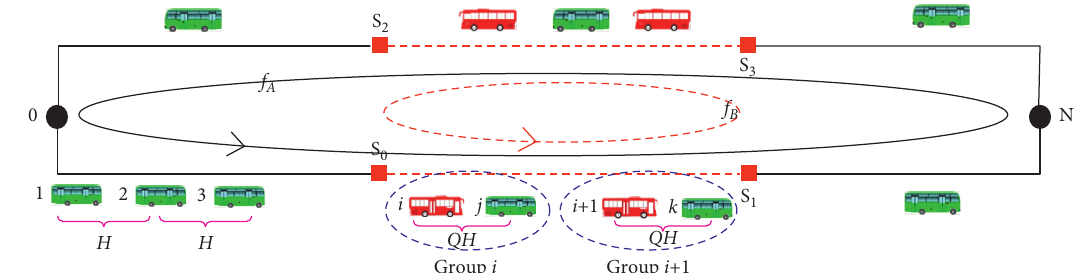
Figure 4: Schematic diagram of short-turning bus operation.